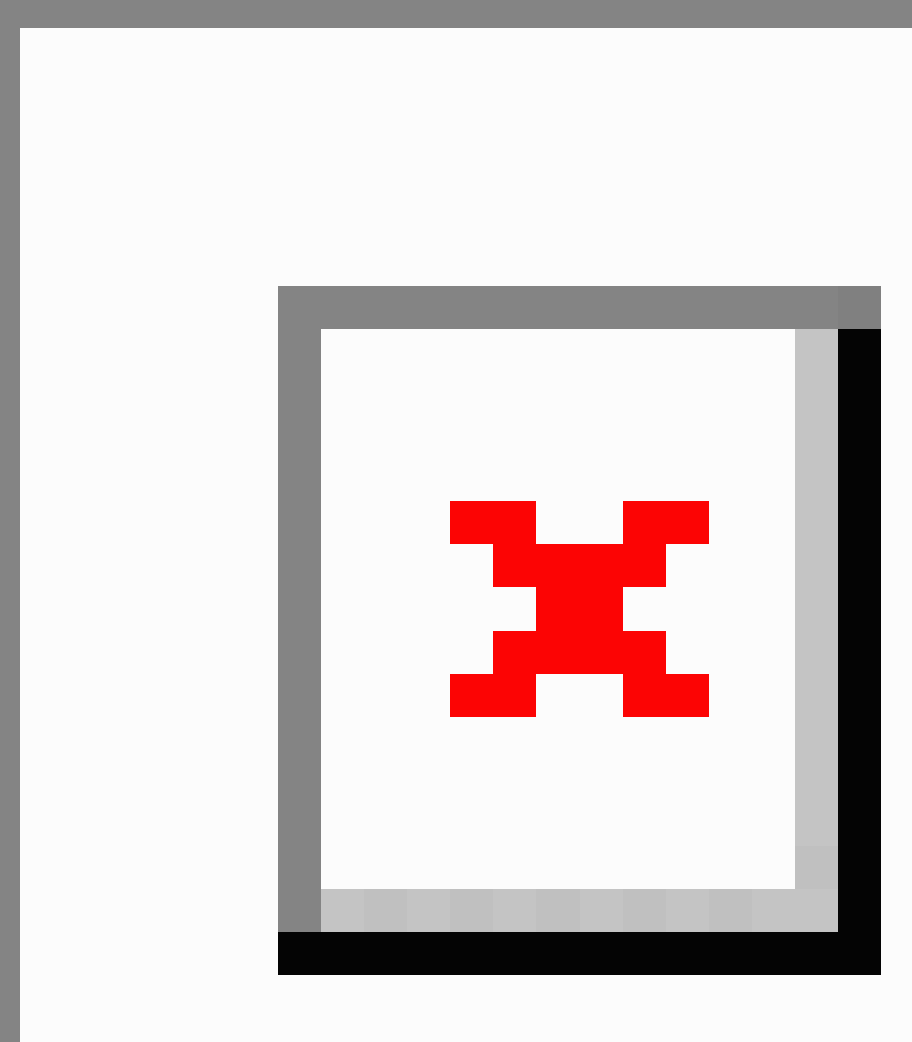
Figure 2. Attribute selection process. DCE: discrete choice